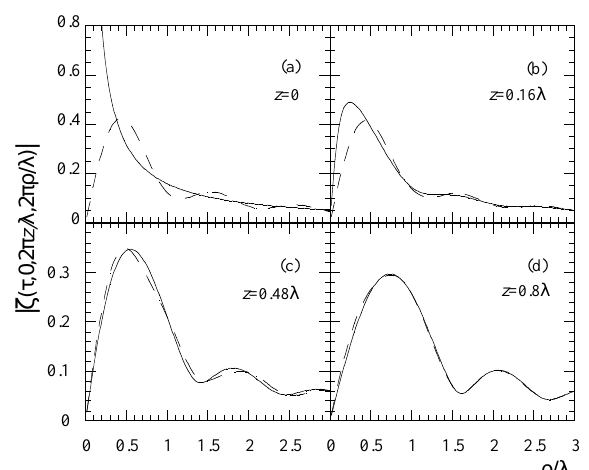
FIG. 2. The dimensionless function z represents the normal- ized radial distribution of the OTR field in the backward di- rection at different distances (cid:122) from the plane of origin for bg (cid:173) (cid:49)(cid:48)(cid:48)(cid:48) . The radial coordinate is given in units of the wavelength. Solid lines correspond to t (cid:173) ‘ and dashed ones to t (cid:173) (cid:49) .